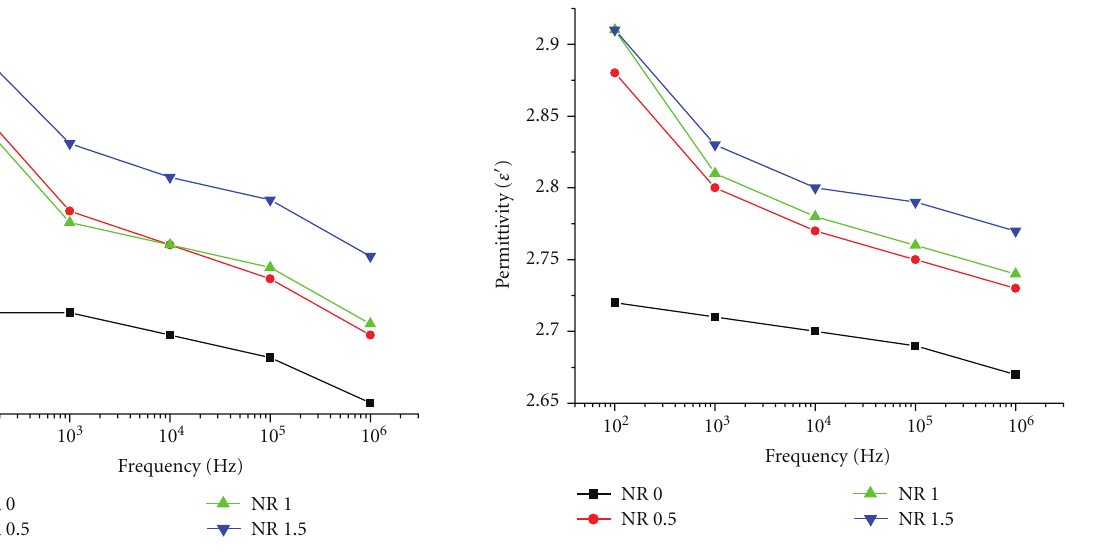
Figure 6: Frequency dependence of dielectric permittivity at di ff erent degree of fullerene filling, at 30 ◦ C.